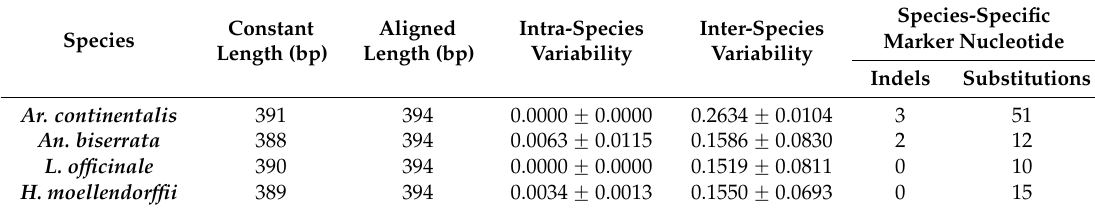
Table 2. Characteristics of ITS2 barcode